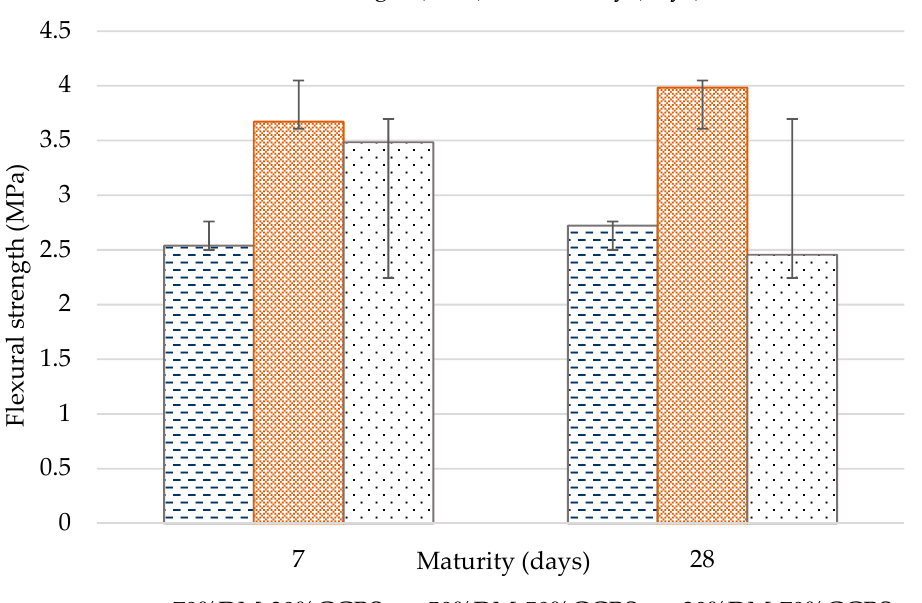
Figure 7. Flexural Strength vs. Maturity per Mixture.